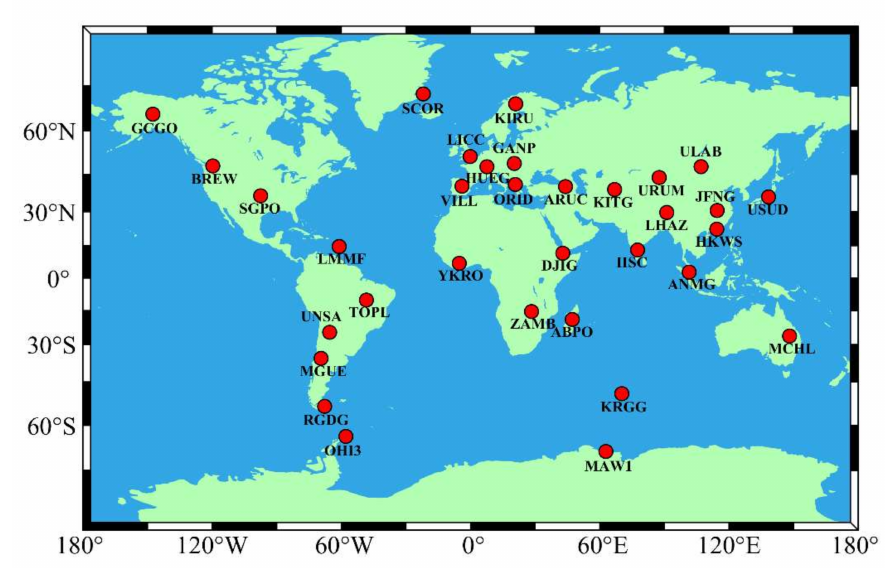
Figure 1. Distribution of the 33 MGEX stations used in this